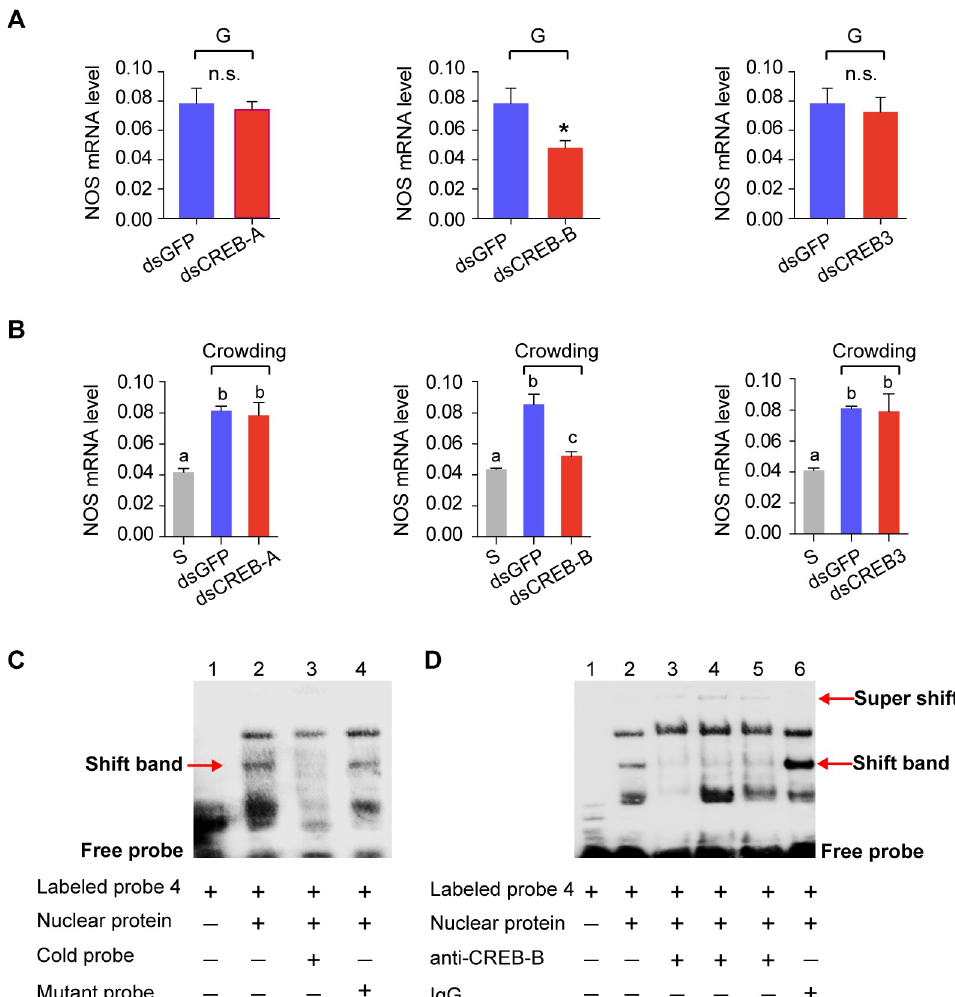
Fig 2. CREB-B interacts with NOS promoter region and regulates NOS transcription in the locust brain. Effects of RNAi-mediated silencing of CREB encoding genes on NOS transcription (A) in the G-phase locusts (n = 4 replicates, 6–8 locusts/replicate, Student’s t-test, � P < 0.05) and (B) in the forced crowding S-phase locusts (n = 4 replicates, 6–8 locusts/replicate, one-way ANOVA, P < 0.05). (C) Electrophoretic mobility shift assay (EMSA) of binding of the nuclear proteins extracted from the brain tissues to the CREB-response element (CREB R4) of the NOS promoter. Nuclear proteins extracted from the locust brain were used to bind with the biotin-labeled CREB R4 probe (CTAGCGCGCGTGACGTGCCCCGGCT). The cold CREB R4 probe was unlabeled. For the mutated probe, TGACG at 11–15 nt of the wild type CREB R4 probe was replaced by TTTTT (CTAGCGCGCGTTTTTTGCCCCGGCT). (D) Validation of the binding of CREB-B protein with the NOS promoter by super-shift assay. Specific antibody of CREB-B (lane 3: monoclonal rabbit antibody against p(S133)-CREB1; lane 4: polyclonal antibody rabbit against p(S133)-CREB1; lane 5: polyclonal rabbit antibody against CREB-B) were used to form the supershift band. Rabbit IgG was used as the